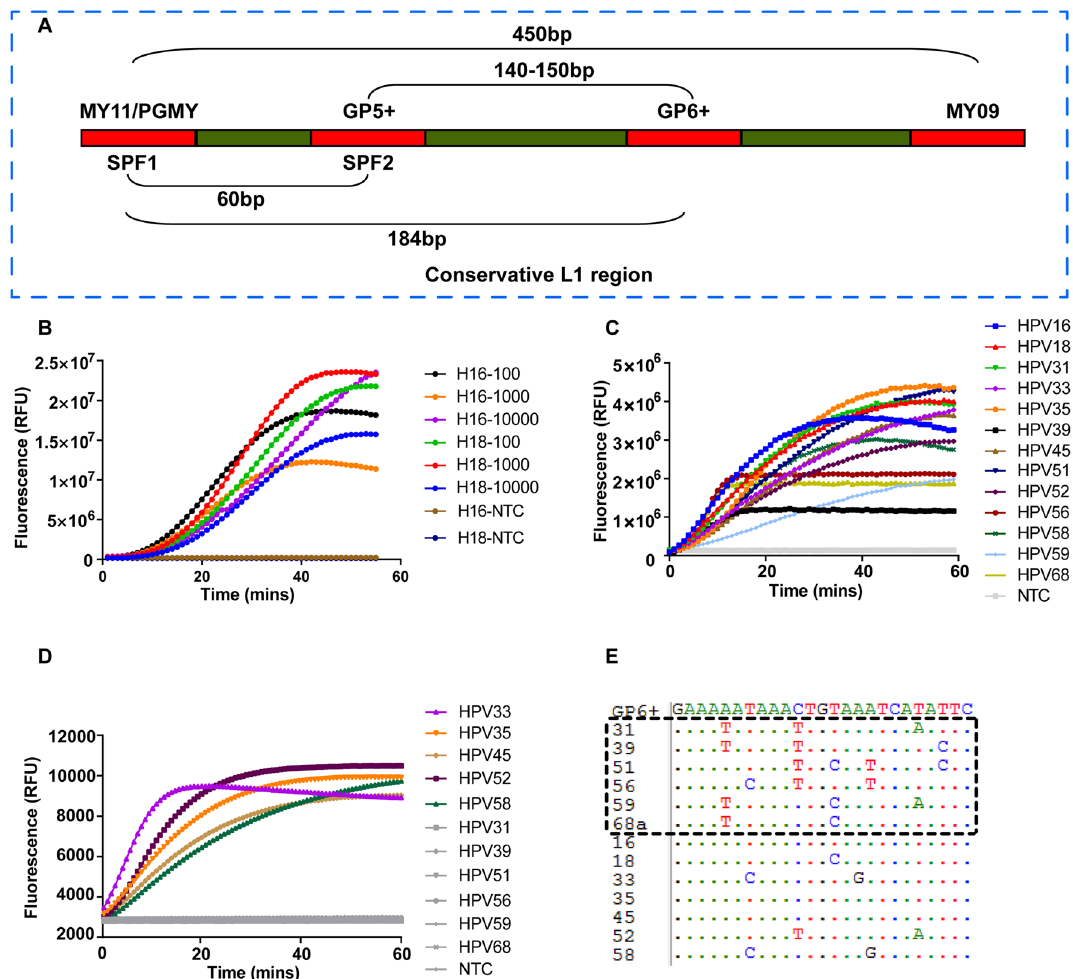
Figure 2. Evaluation of the PGMY/GP6+ primer pool. ( A ) Schematic showing the relative position of the primer sets locating in the conservative L1 region of HPV. ( B ) Plasmids with different copy numbers of HPV16 and HPV18 were amplified by RPA reaction using the PGMY/GP6+ primer pool. NTC no-template control. ( C ) Real-time fluorescence detection of HPVs with the crRNA pool containing 11 crRNAs. For a single reaction, 5 μg of each individual HPV plasmid was used. NTC no-template control. ( D ) The PGMY/GP6+ pool was tested using 10,000 copies of the indicated HPV plasmids for each RPA reaction. The RPA reaction was performed at 37 °C for 20 min and followed by Cas12a detection at 37 °C for up to 60 min. NTC no-template control. ( E ) Nucleotide sequence alignments of GP6+ (positions 5879 to 5903 according to HPV16 sequence, Genbank accession number NC_001526.4) to 13 HR-HPV genotypes. HPV genotypes are specified by numbers on the left. Dots indicate the presence of nucleotides identical to the top sequence (GP6+). HPV Types with weak amplification by the primer pool are shown by